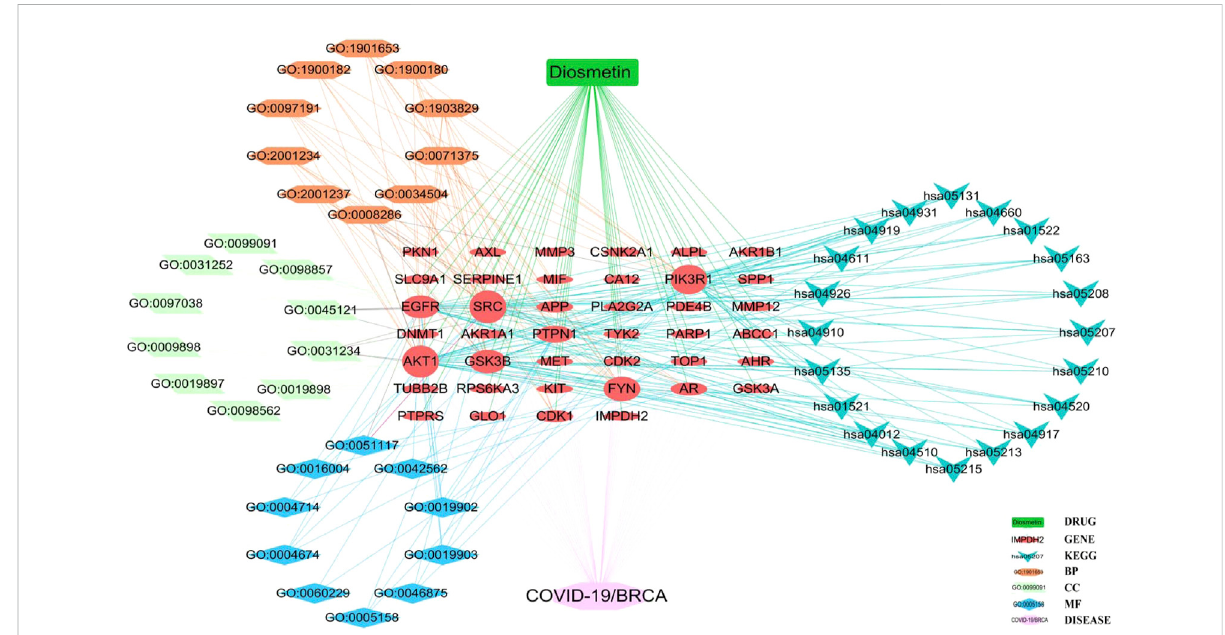
FIGURE 7 Core biological targets, pharmacological functions, and interaction networks of the signaling pathways of Diosmetin against BRCA/COVID-19.